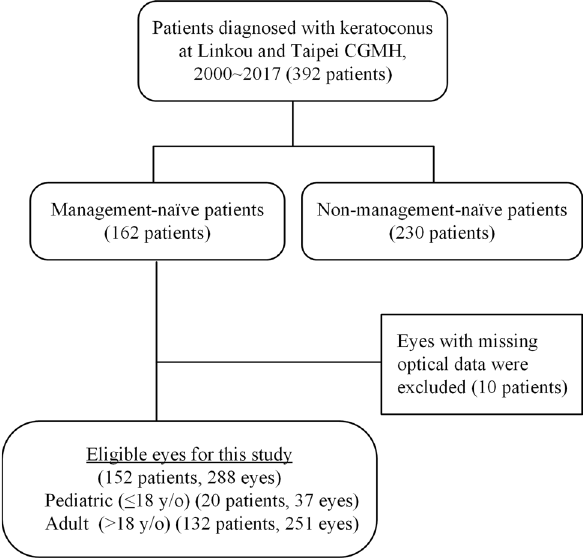
Figure 4. Flowchart of eligible keratoconus patients included in the